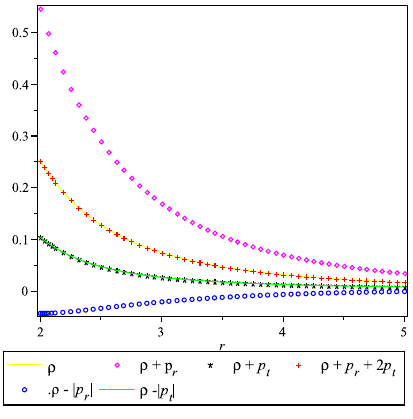
(f) This figure depicts the behavior of all EC terms for Model-I in Subcase 9 ( ξ 1 > 0, α 1 > 0, β 1 > 0, α > 0). All ECs are shown to satisfy for every r >